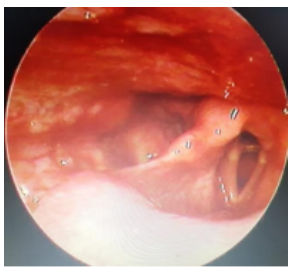
Figure 12. Left RLN palsy